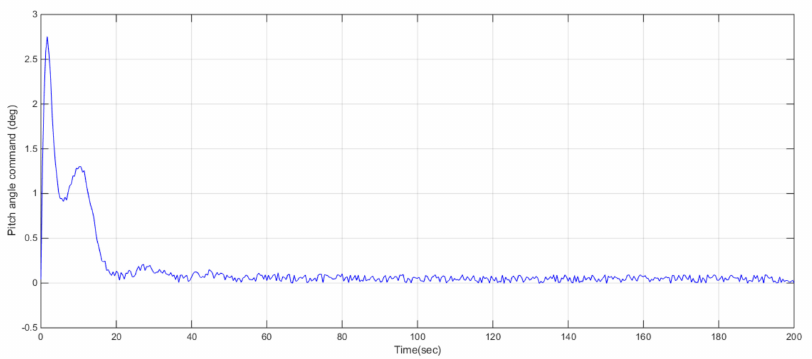
Figure 9. β d control input with fault.